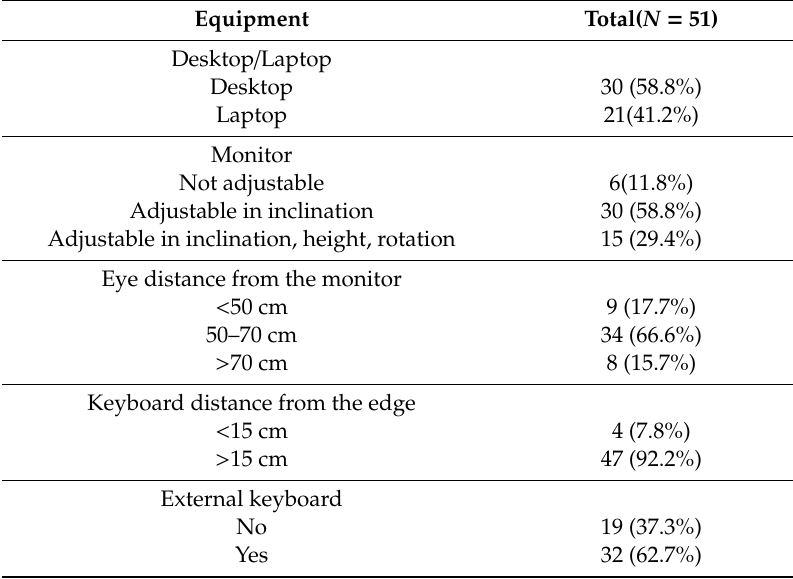
Table 9. Home working equipment characteristics: computer and